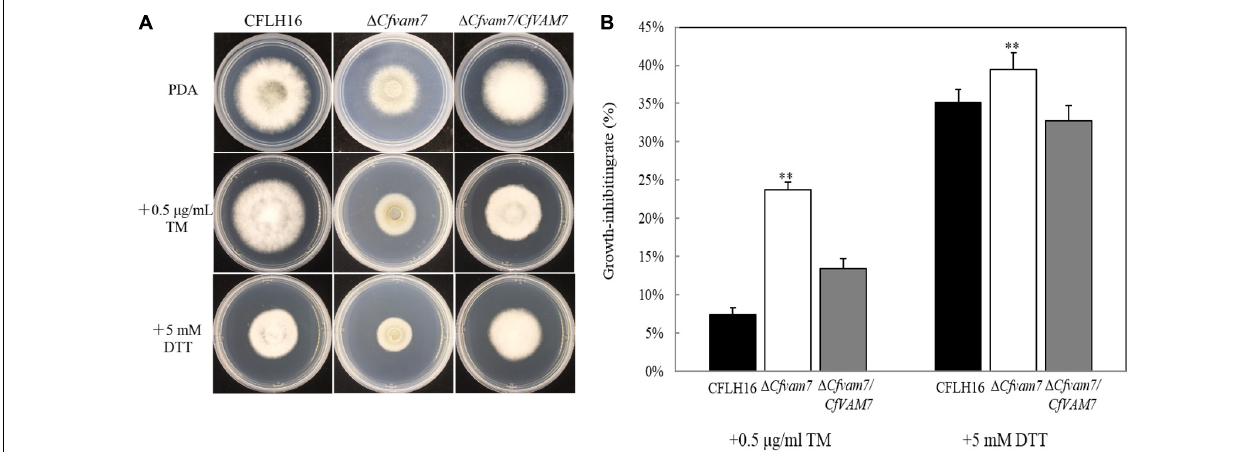
FIGURE 5 | CfVam7 participates in the responses to endoplasmic reticulum (ER) stresses. (A) The wild type (WT), (cid:49) Cfvam7 , and (cid:49) Cfvam7 / CfVAM7 were incubated on potato dextrose agar (PDA) plates with 0.5 µ g/ml of tunicamycin (TM) and 5.0 mM of dithiothreitol (DTT) at 28 ◦ C. (B) Statistical analysis of inhibition rates of the strains to TM and DTT stress. Error bars represent SD of three replicates, and “**” indicate significant difference ( p < 0.01).